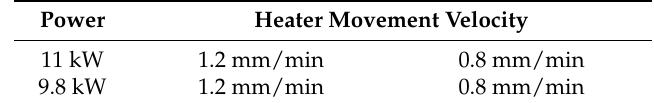
Table 1. Experimental parameters.